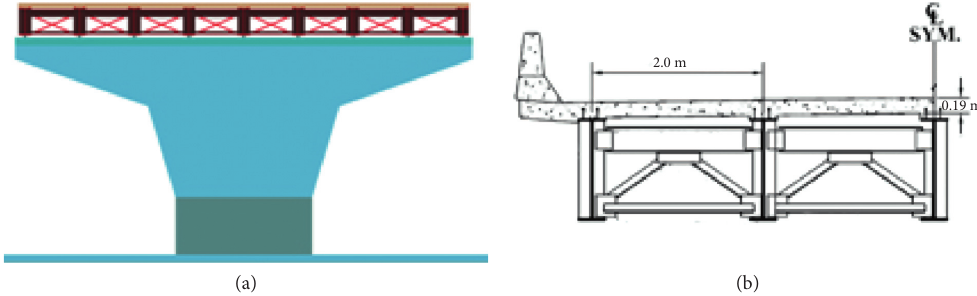
Figure 9: Hongqi Bridge with steel girder-slab: (a) girders’ properties according to Maleki’s research [21] and (b) modeling in